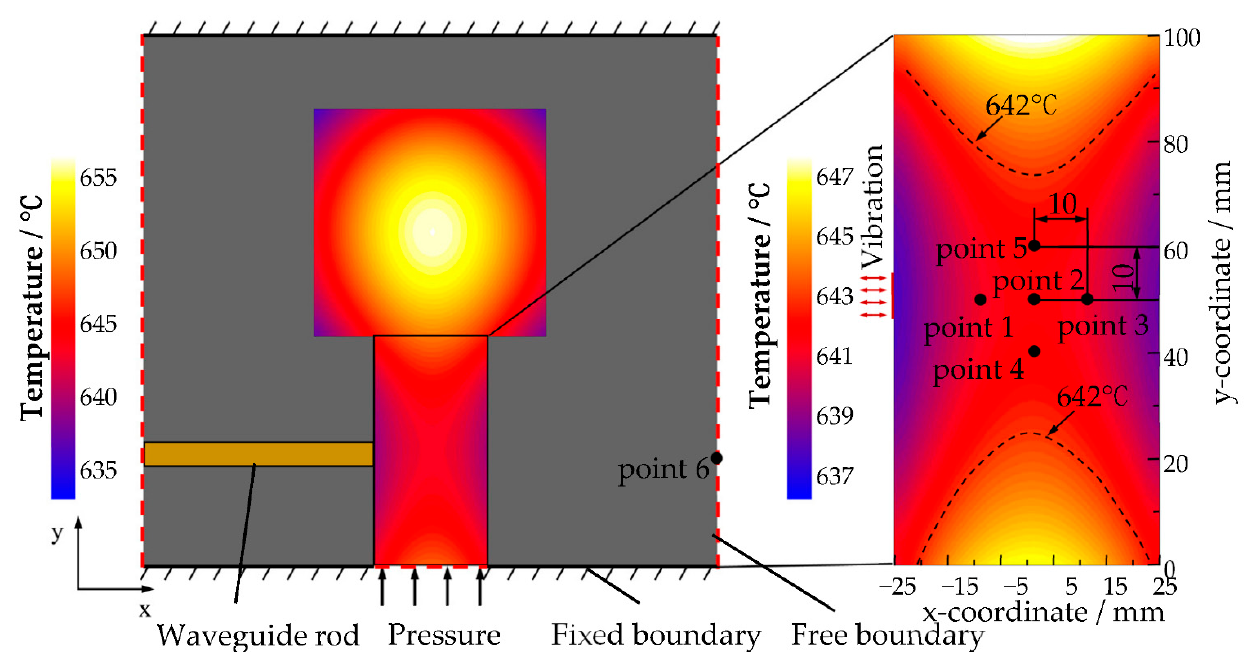
Figure 2. The boundary conditions for simulating the wave field, the locations of the representative points 1–6, and the temperature field at the 30% solid fraction of the feeding channel.